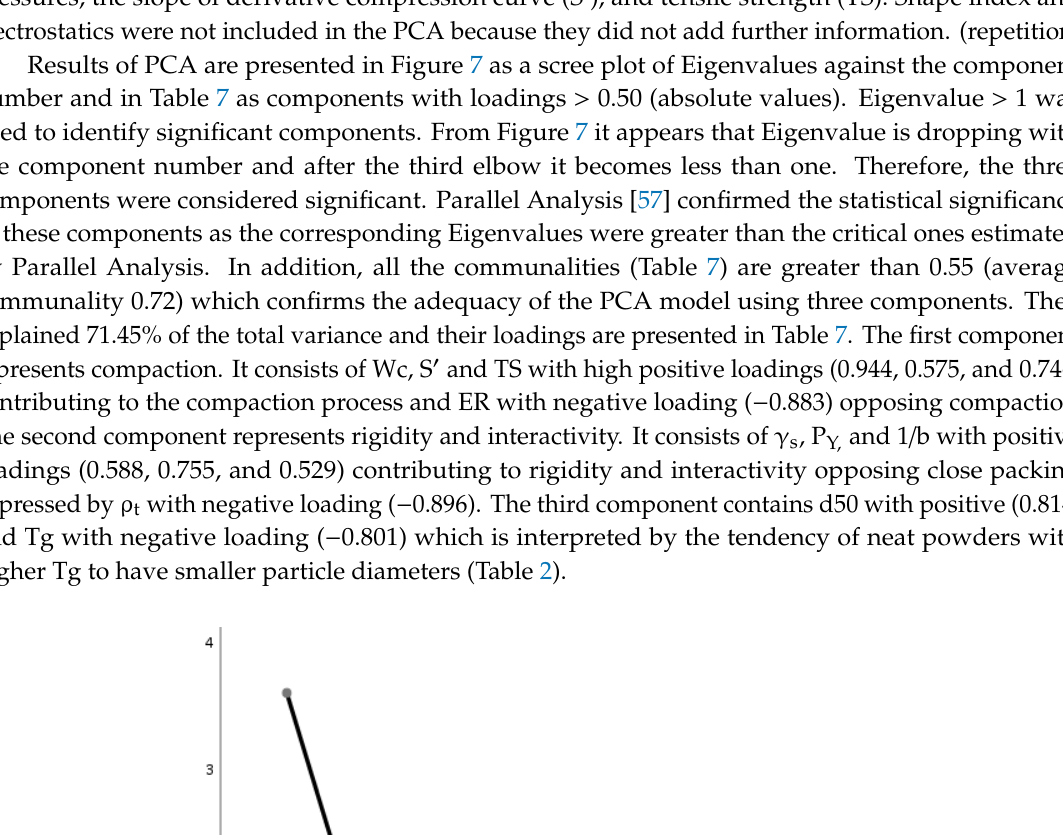
Table 7. Components obtained from the Principal Component Analysis (varimax rotation) with loadings greater than 0.5.